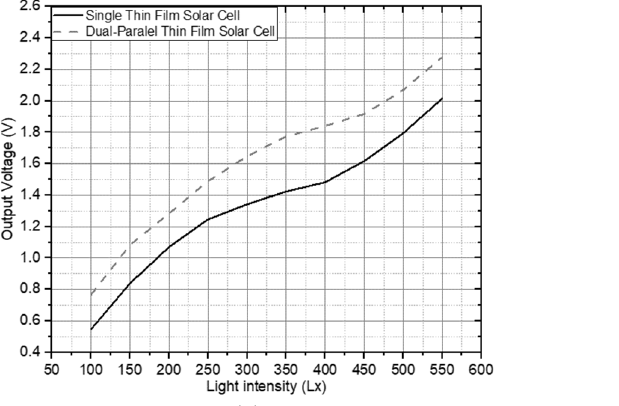
Figure 14. Spectrum graph of the signal reception level by the CP antenna.